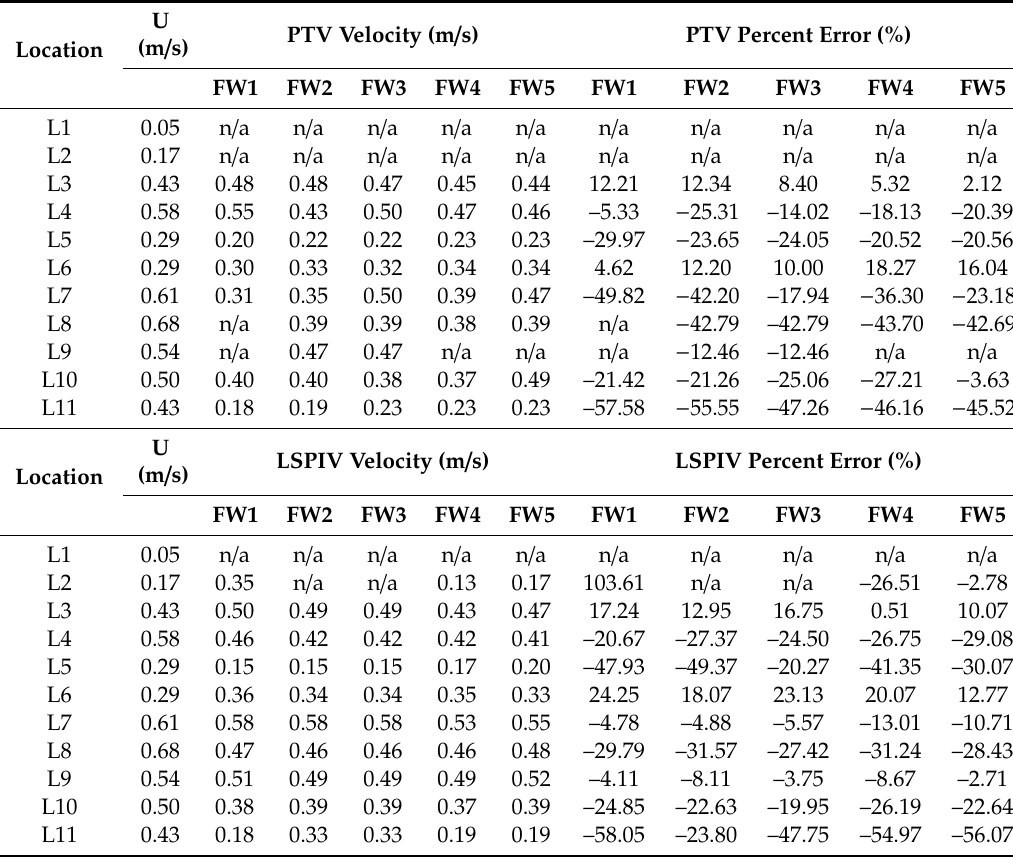
Table A3. PTV and LSPIV results for each location compared to reference measurements on the Basento